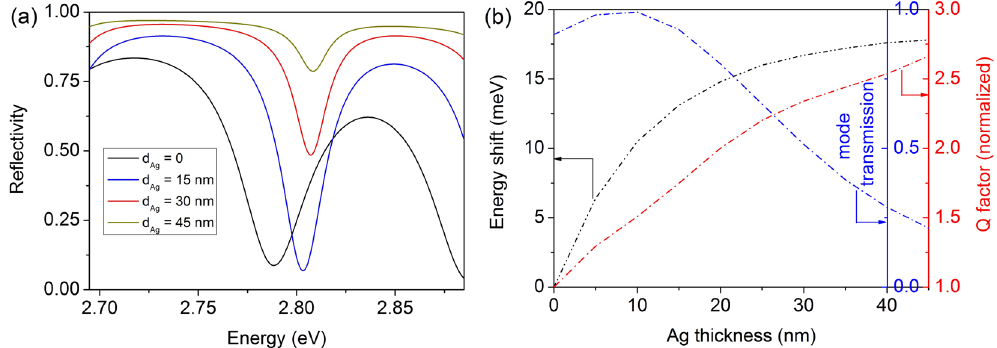
Figure 4. ( a ) Calculated reflectivity spectra of the cold Bragg structure in the vicinity of the first BM for different thicknesses of the Ag layer. ( b ) Calculated spectral position (black), the Q factor (red), and the mode transmission (blue dash-dotted line) of the first BM as a function of the thickness of the Ag